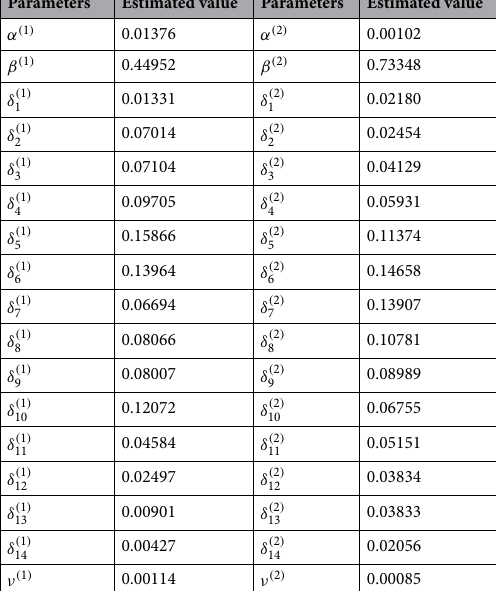
Table 2. The estimated values of the model parameters for two different time domains defined in Eq.